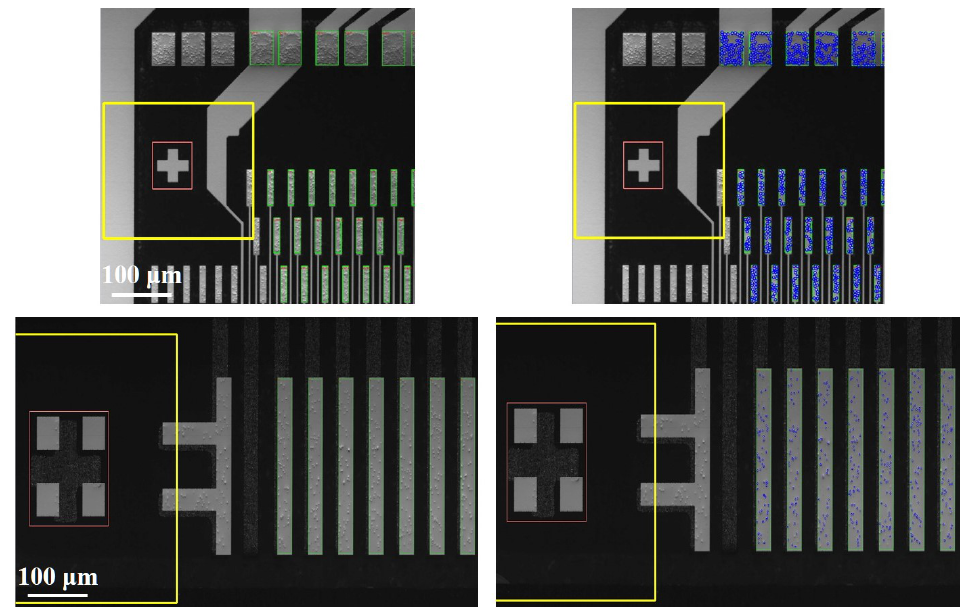
Figure 13. The first row is a part of the bump area of the COG sample ( left ) and the corresponding result ( right ), while the second row displays the input and output of the FOG test in the same order. Figure 14 looks closer at bar-like bump areas. Bumps with an insufficient number of particles would be sent to NG output based on the manufacturer’s requirement.